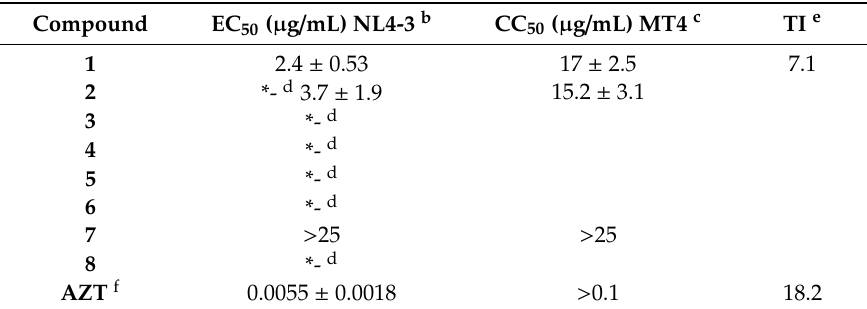
Table 2. In vitro anti-HIV data of compounds 1 – 8 a